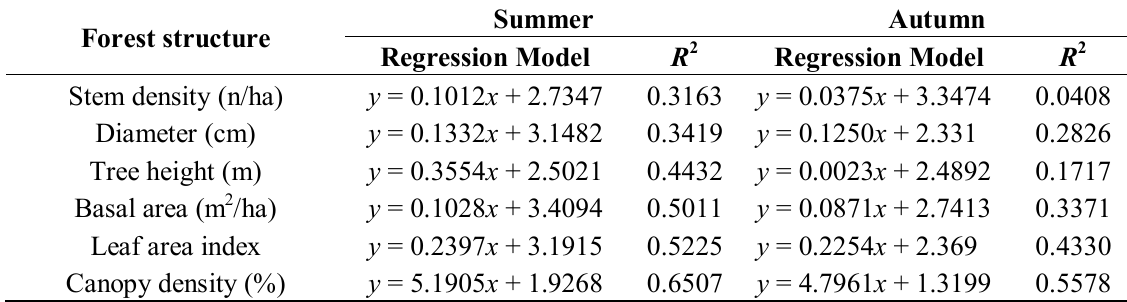
Table 5. Regression analysis of urban vegetation structure of park and PCI at different seasons ( n = 33, P <